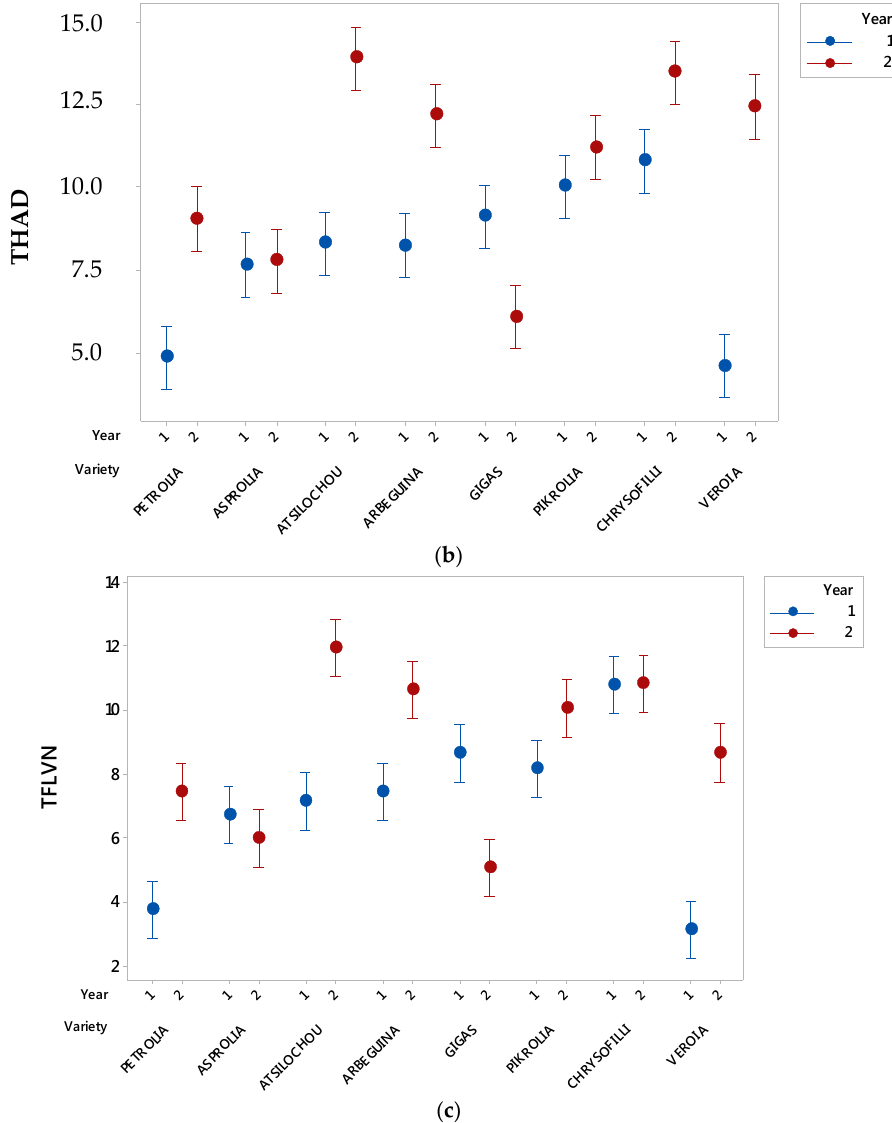
Figure A1. Effect of year and variety on total phenol content determined via the alternative spectrophotometric assay (TPHCl), total hydroxycinnamic acid derivatives (THCAD), and total flavonols (TFLVN) contents. Vertical bars denote the 95% confidence intervals of means calculated from the error mean square of the analysis of variance. Means whose 95% intervals do not overlap differ statistically significantly.